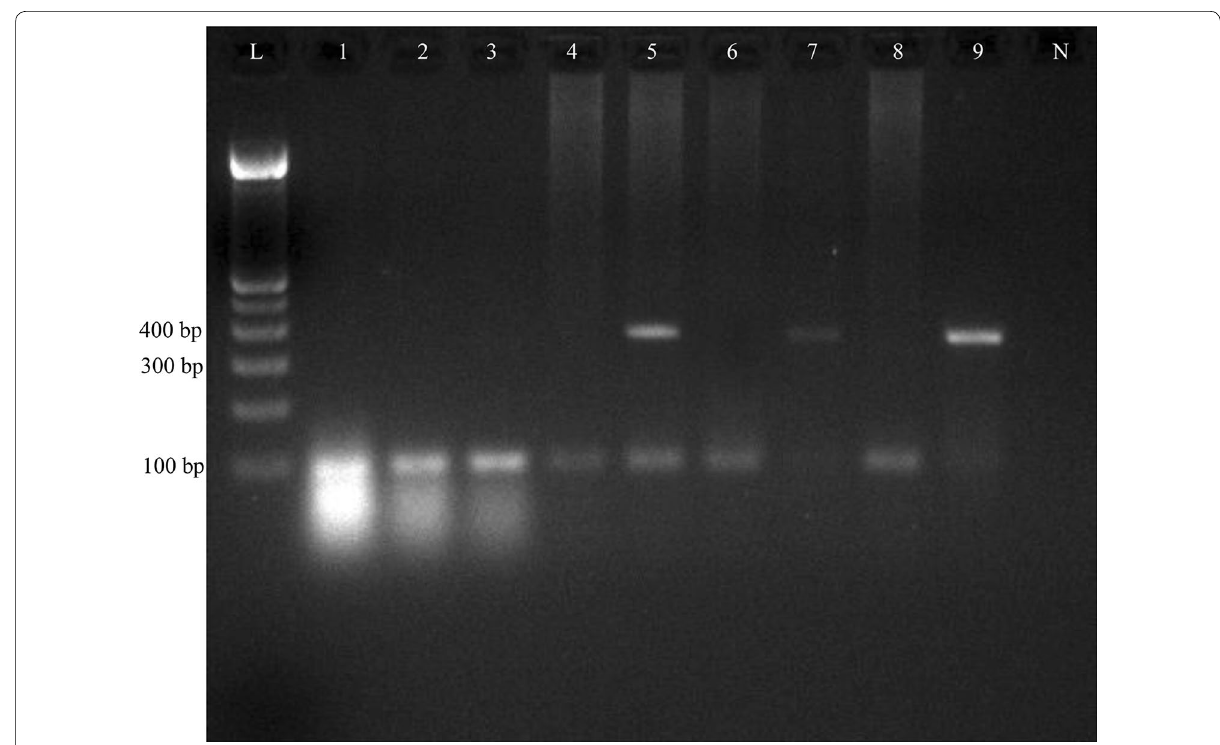
Fig. 1 Duplex PCR results on the 2% Agarose gel. L, 100 bp ladder; N, negative control; lane no 1–4 , 6 and 8 , C. albicans ; lanes 7 and 9 , C. dubliniensis ; lane 5 , positive for both C. albicans and C. dubliniensis